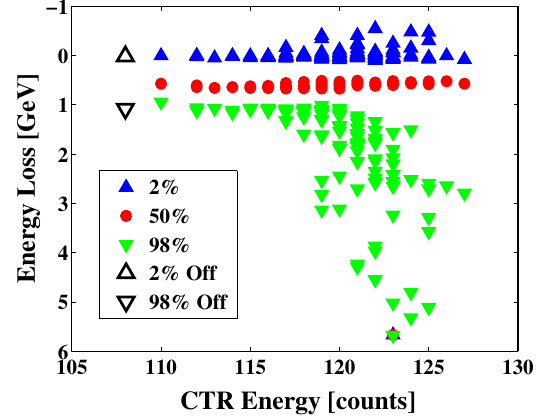
FIG. 8. (Color) Changing bunch length (Xe)—Distribution of the 2%, 50%, and 98% charge levels as a function of increasing CTR energy or decreasing bunch